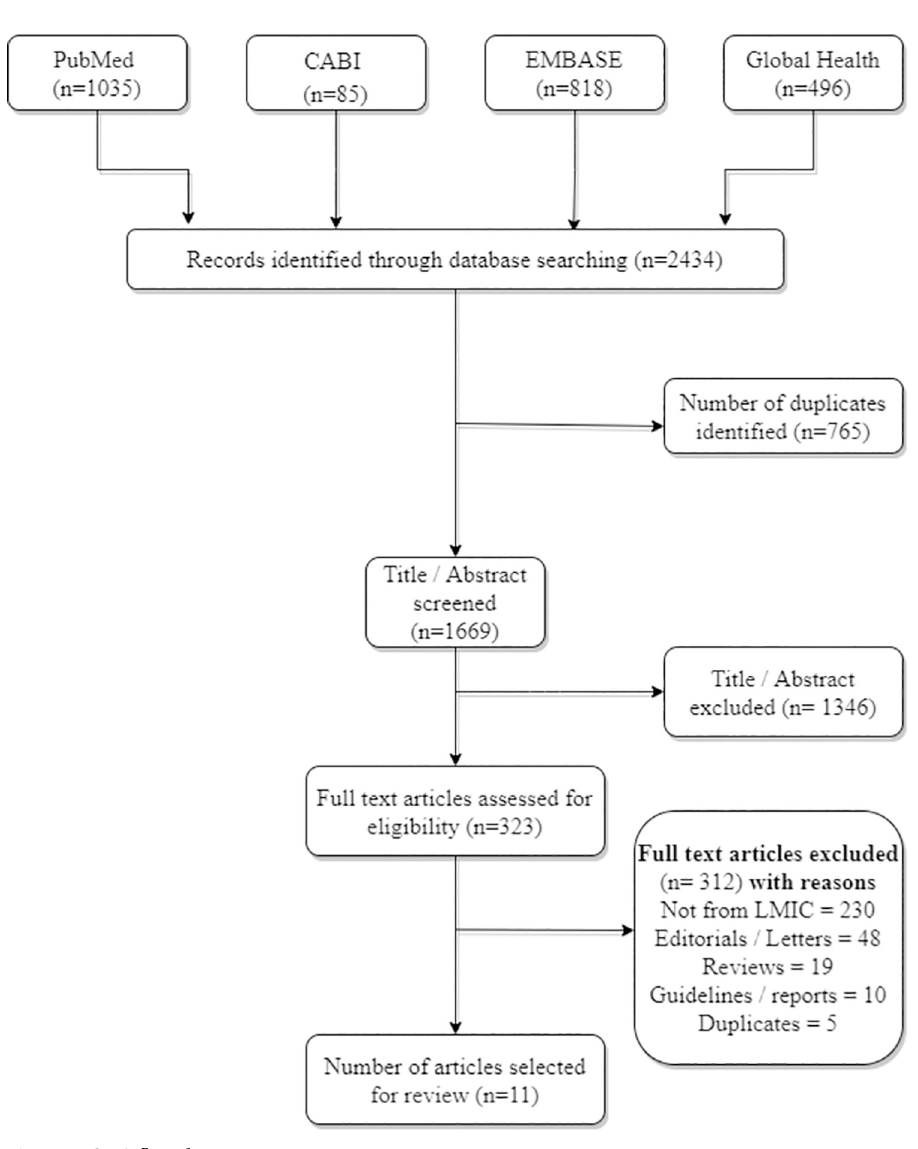
Fig 1. PRISMA flow